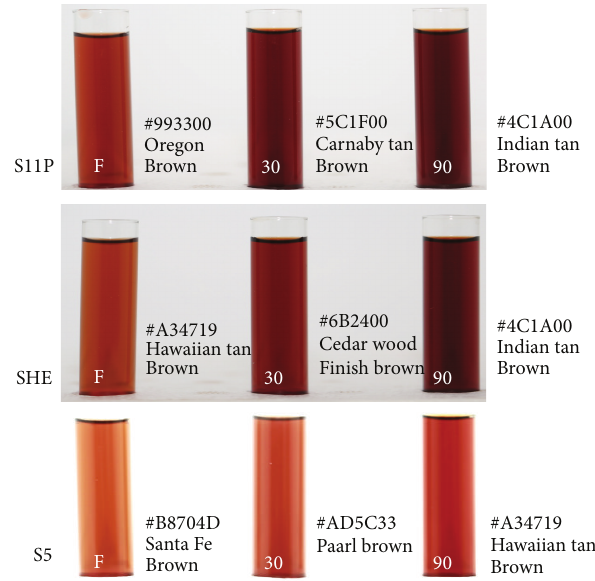
Table 2: The 3 selected isolates SHE, S11P and S5, response to the produced nano particles and drug of choice against ATCC